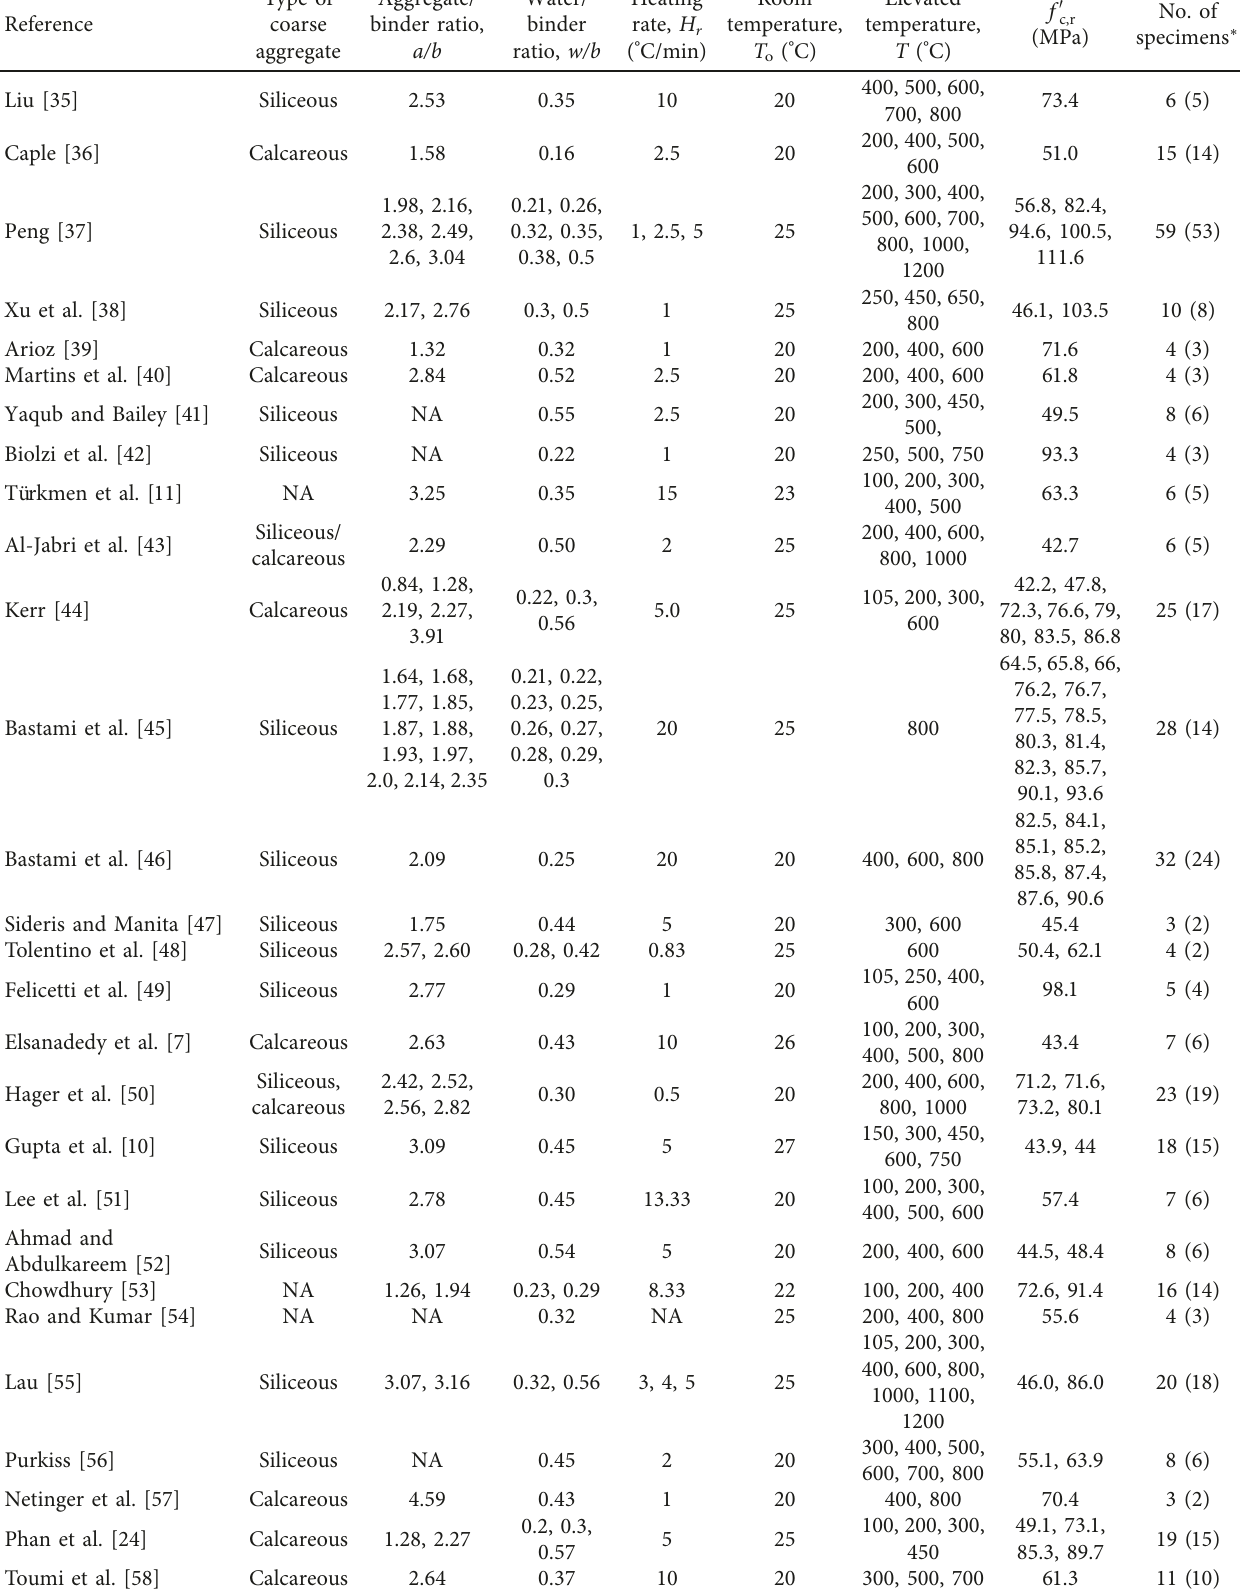
Table 2: Summary of the experimental database used in this study ↑